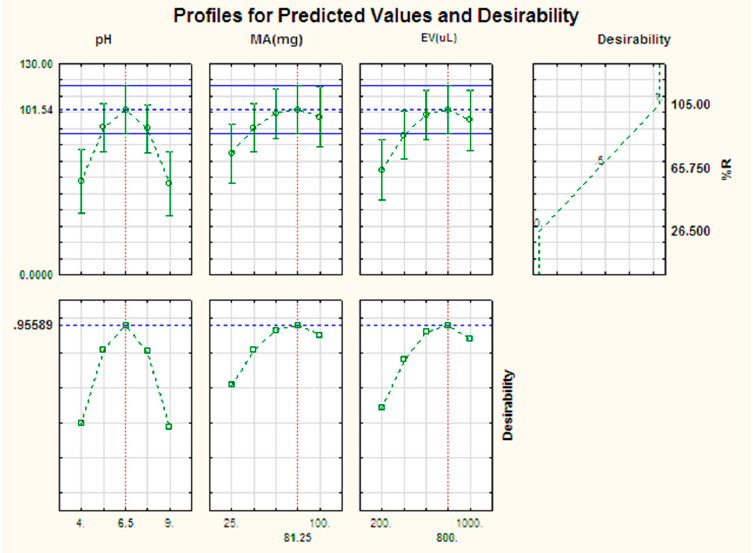
Figure 3. Profiles for predicated values and desirability function for pre-concentration of parabens.